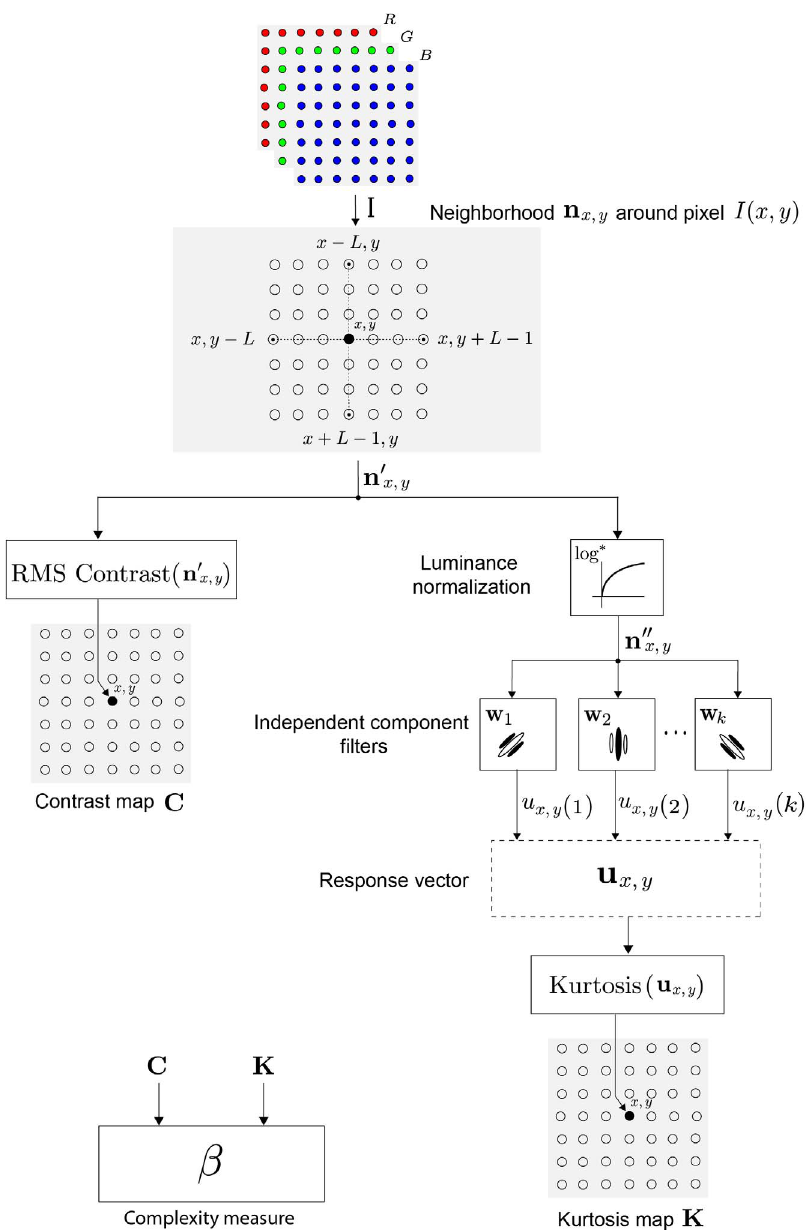
Figure 2. Block diagram of the objective ranking system. The RGB bands of the input streetscape are collapsed to form a grayscale image I . Around every pixel I ( x , y ) , a neighborhood n x , y of 2 L | 2 L pixels is considered. After vectorization, each neighborhood n 0 workflows. The first workflow (left) creates a contrast map C where each C ( x , y ) is calculated as the root-mean-squared (RMS) contrast of n 0 has its luminance intensities normalized by means of a log transform. Secondly, the responses of independent second workflow (right), n 0 x , y component (IC) filters to the normalized neighborhood form the response vector u x , y . The kurtosis map K is calculated so that each K ( x , y ) is the kurtosis value of the response u x , y . The proposed measure b is calculated based on statistics of contrast and kurtosis